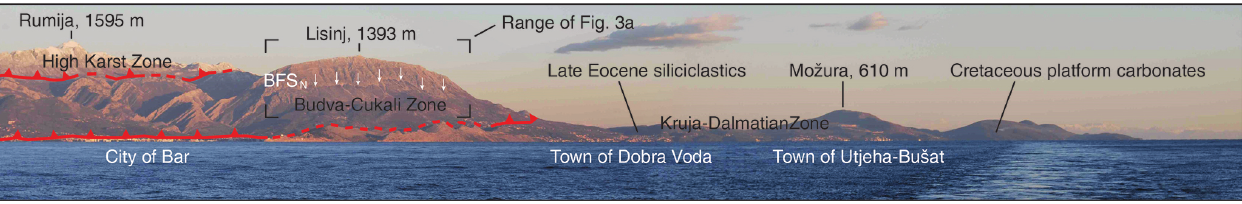
Figure 2. Panoramic view from aboard the Meteor research vessel cruise no. 86, leg 3 SE towards the Montenegro coast, including BFS N . Basal thrusts separating the large-scale tectonic units and a choice of other landmarks are sketched.